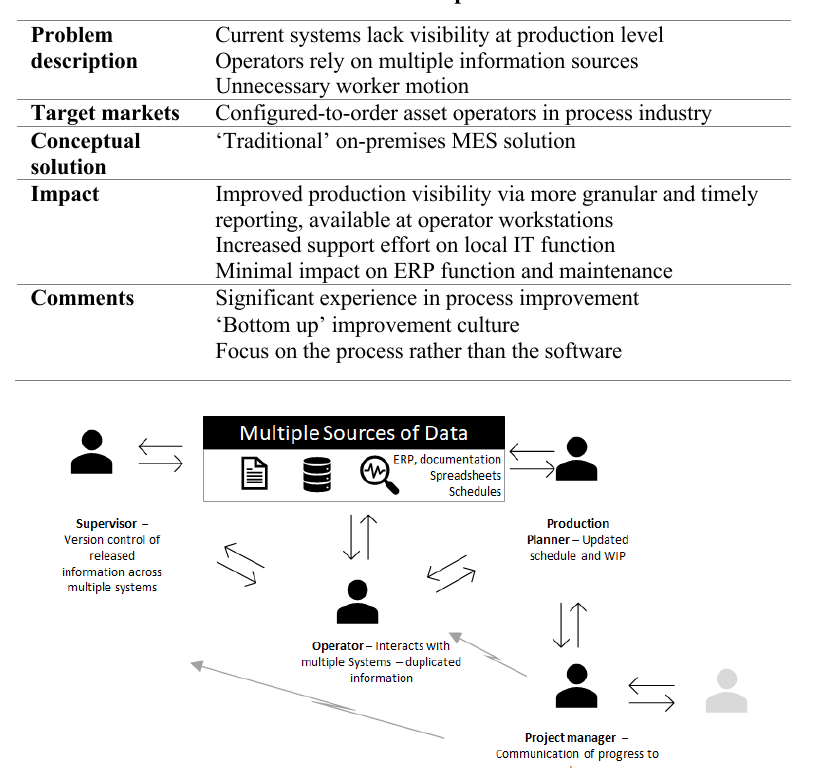
Table 2 Contextual description for case 1